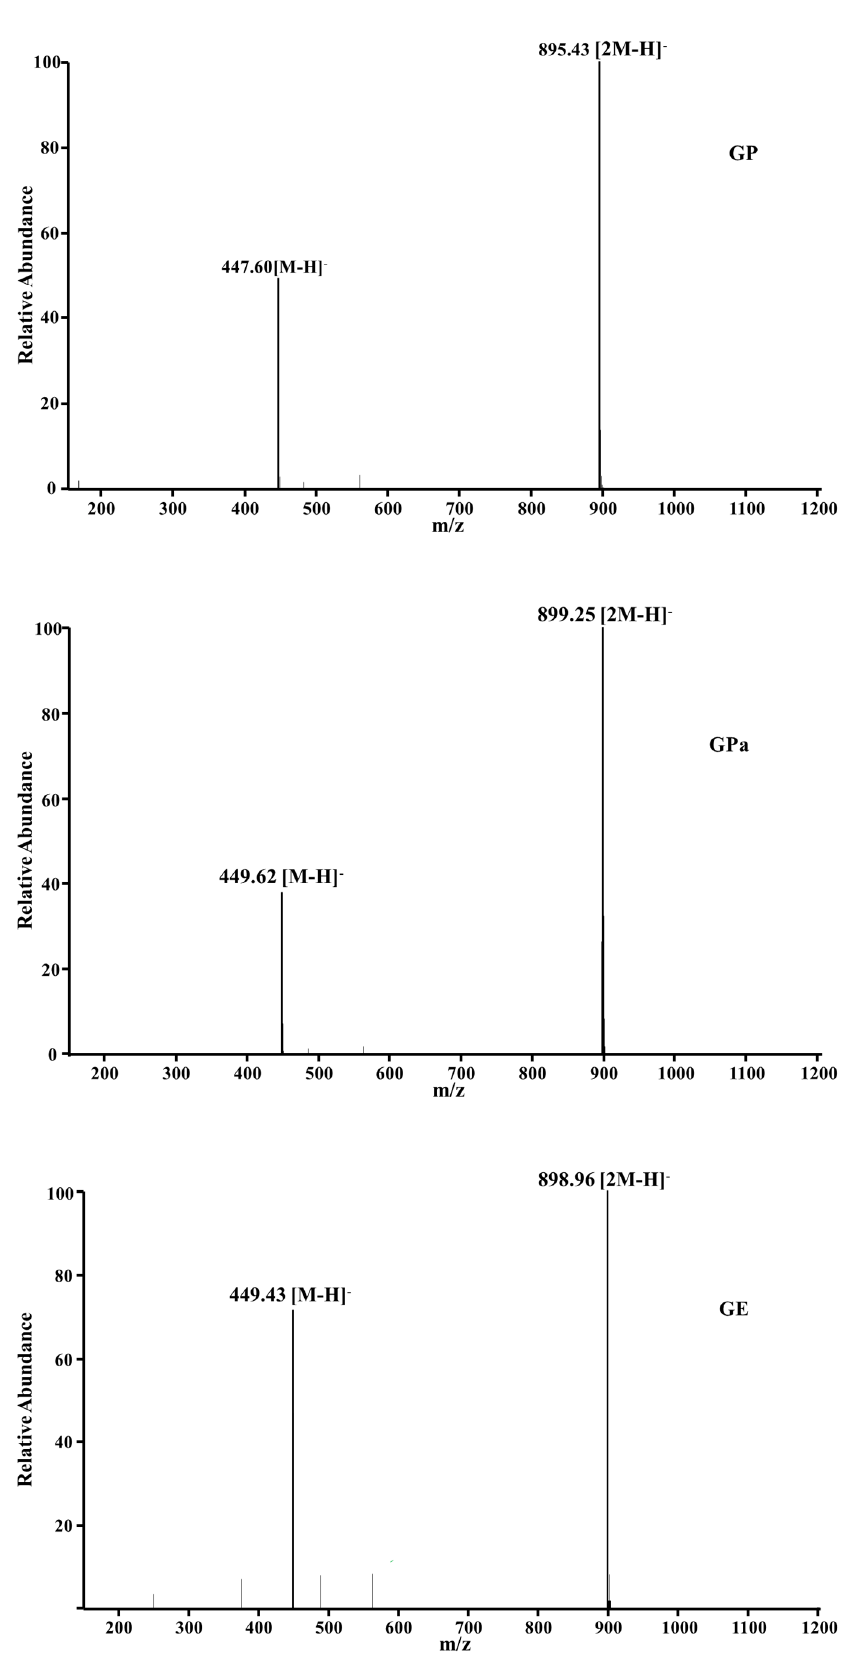
Figure 4. MS spectrum of GP, GPa, and GE.